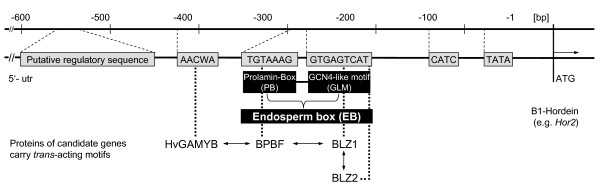
Interplay between the candidate genes and the promoter region of a target gene (e.g. Hor2). Transcription start is displayed as ATG. Arrows to both sides show known interactions between the four transcription factors BLZ1, BLZ2, BPBF and HvGAMYB. Grey boxes indicate cis-regulatory motifs named as mentioned in the black boxes.